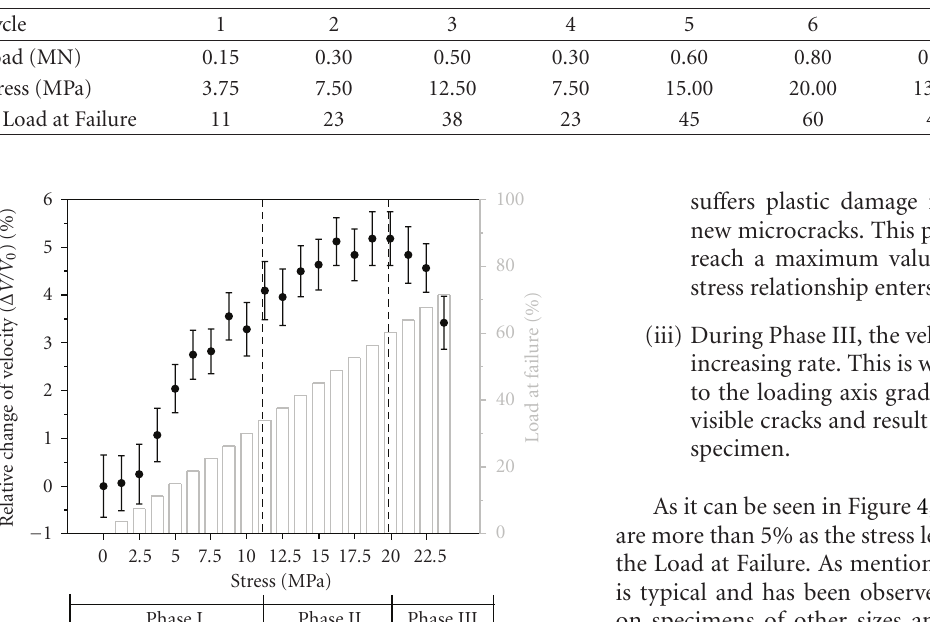
Table 2: The maximum level of applied load in each cycle in terms of load, stress, and percentage of the load at failure.